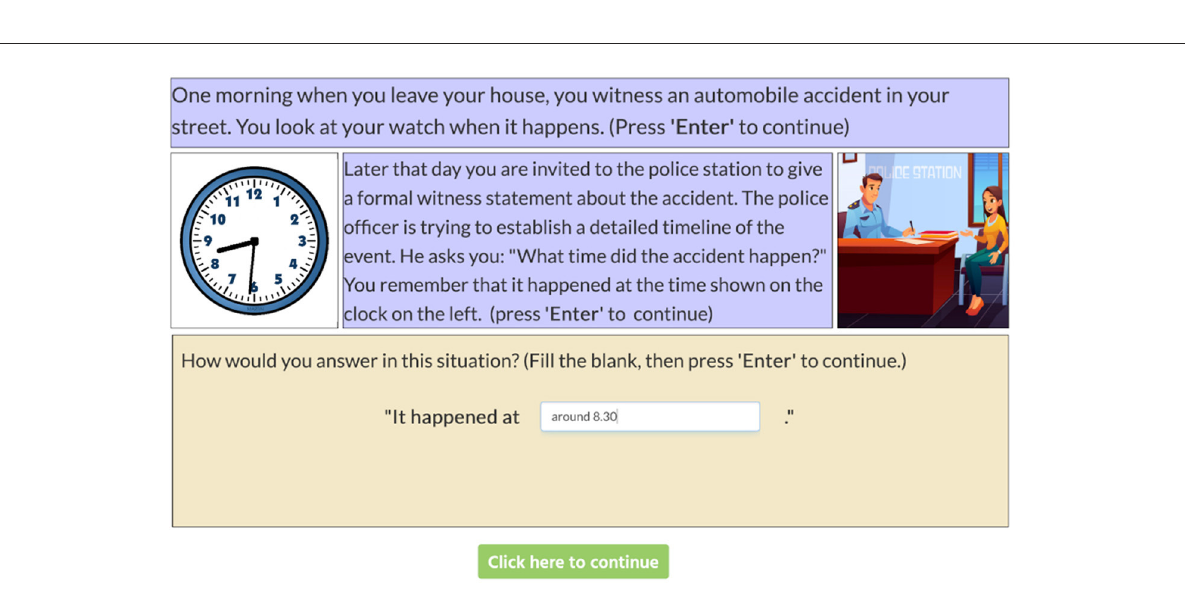
FIGURE7 Project A05: Screenshot from production experiment—police station context (image from